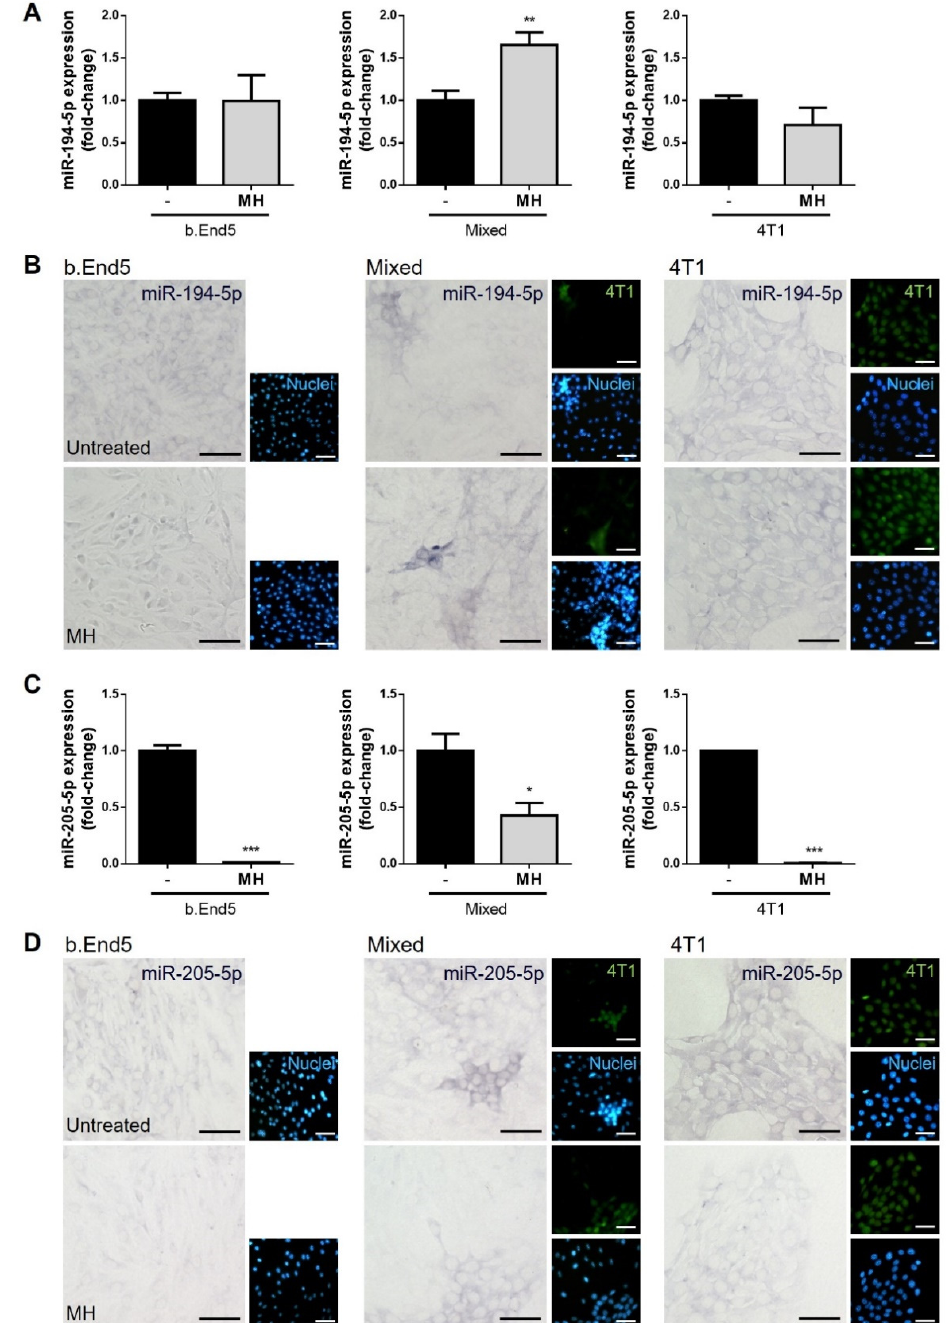
Figure 10. MH modulates miRNAs release and expression. Single cultures of 4T1, b.End5, and mixed cultures of b.End5 and 4T1 cells (previously labelled with CellTracker™ CMFDA Green Dye), under physiological shear stress, were treated with MH (1 µM), or DMEM (untreated), for 24 h, after which the media were collected and processed for RT-qPCR of the indicated miRNAs, while the cells were fixed and processed for ISH. ( A ) RT-qPCR analysis highlighted the increased miR-194-5p release in mixed cultures, ( B ) mirrored by its increased expression in b.End5 cells, especially in the vicinity of 4T1 clusters. ( C ) Downregulation of miR-205-5p release in single and mixed cultures with MH was observed by RT-qPCR, ( D ) as well as by ISH. RT-qPCR results are presented as fold change vs. untreated. Hoechst 33342 was used as counterstaining for nuclei (blue). Scale bar: 40 µm. Data are represented as mean ± SEM of three independent experiments. Statistical significances are denoted as * p < 0.05, ** p < 0.01, and *** p < 0.001 vs. untreated conditions.